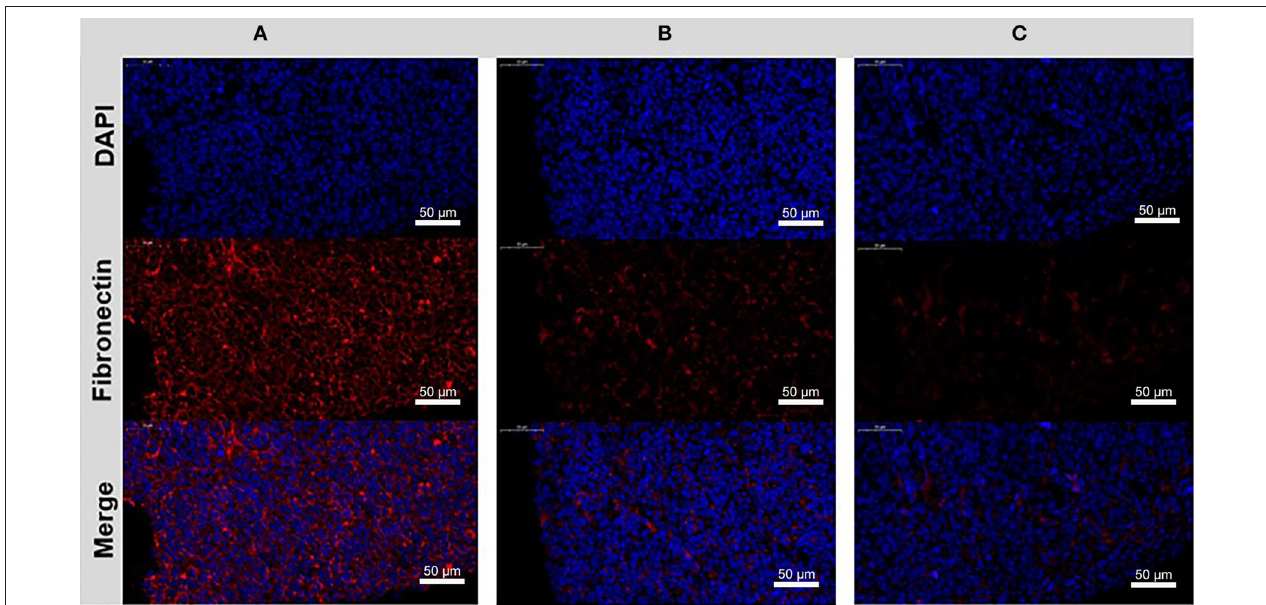
FIGURE 8 | The disrupting effect of CYC treatment to fibronectin in the tumor ECM. Immunofluorescence images of control group (A) , free CYC treatment group (B) , ABN@HA-sese-Ce6/CYC NPs treatment group (C) after 4 times i.v. injection. Blue, nuclei. Red, Fibronectin.